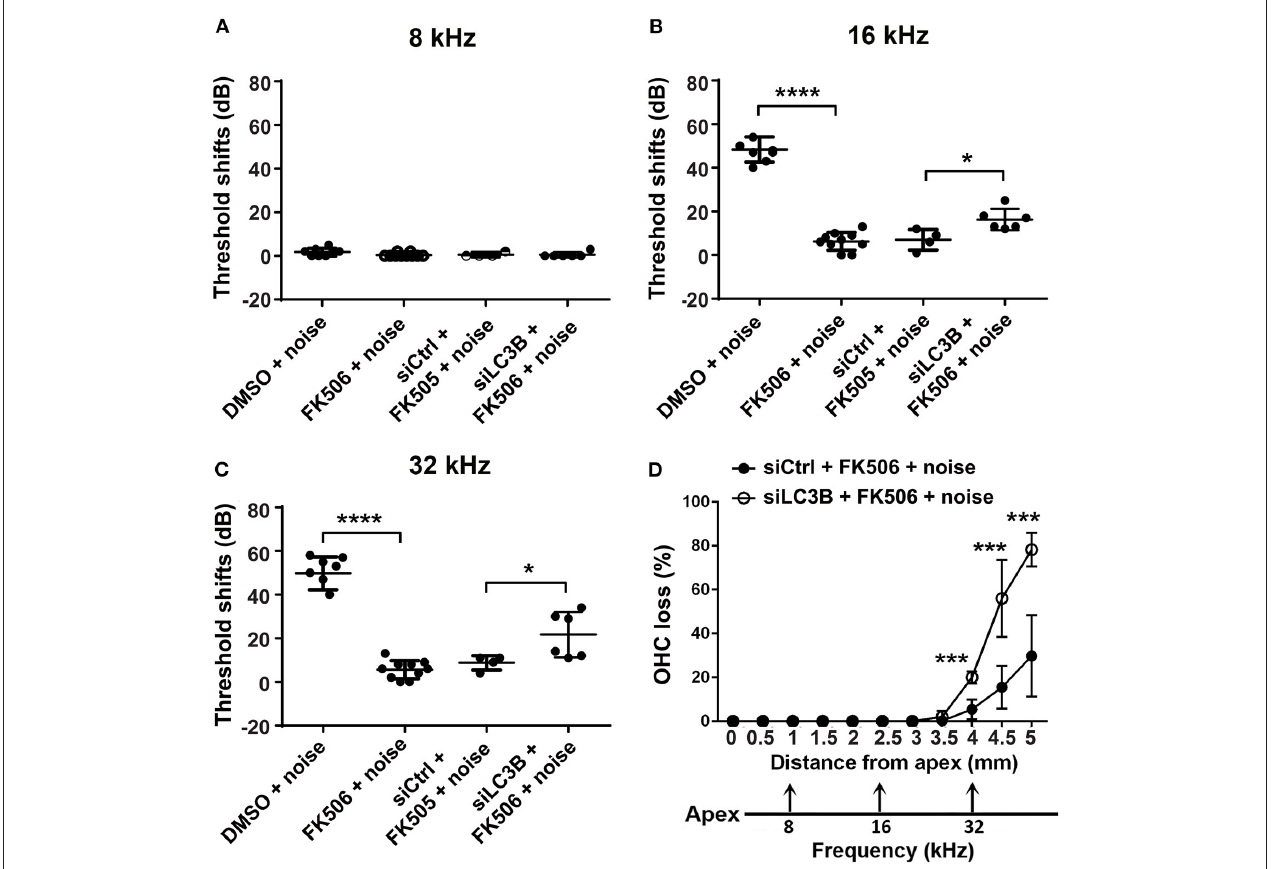
FIGURE 6 | Inhibition of autophagy reduces the protective effects of FK506 against noise-induced hearing loss and auditory outer hair cell (OHC) loss. (A–C) Pretreatment with siLC3B reduces the protective effect of FK506 at 16 and 32kHz when assessed 14 days after exposure. Noise does not induce auditory threshold shifts at 8kHz. Data are presented as individual points for each mouse and means ± SD for each group; * p < 0.05, **** p < 0.0001. (D) Quantitative analysis of loss of OHCs along the entire cochlear spiral shows that the reduction of OHC loss by treatment with FK506 was partially diminished by pretreatment with siLC3B assessed 14 days after exposure. The distances along the cochlear spiral correlating with the frequencies 8, 16, and 32kHz are indicated. Data are presented as means ± SD. siControl + FK506 + noise, n = 4; siLC3B + FK506 + noise, n = 6; ** p < 0.01, **** p <